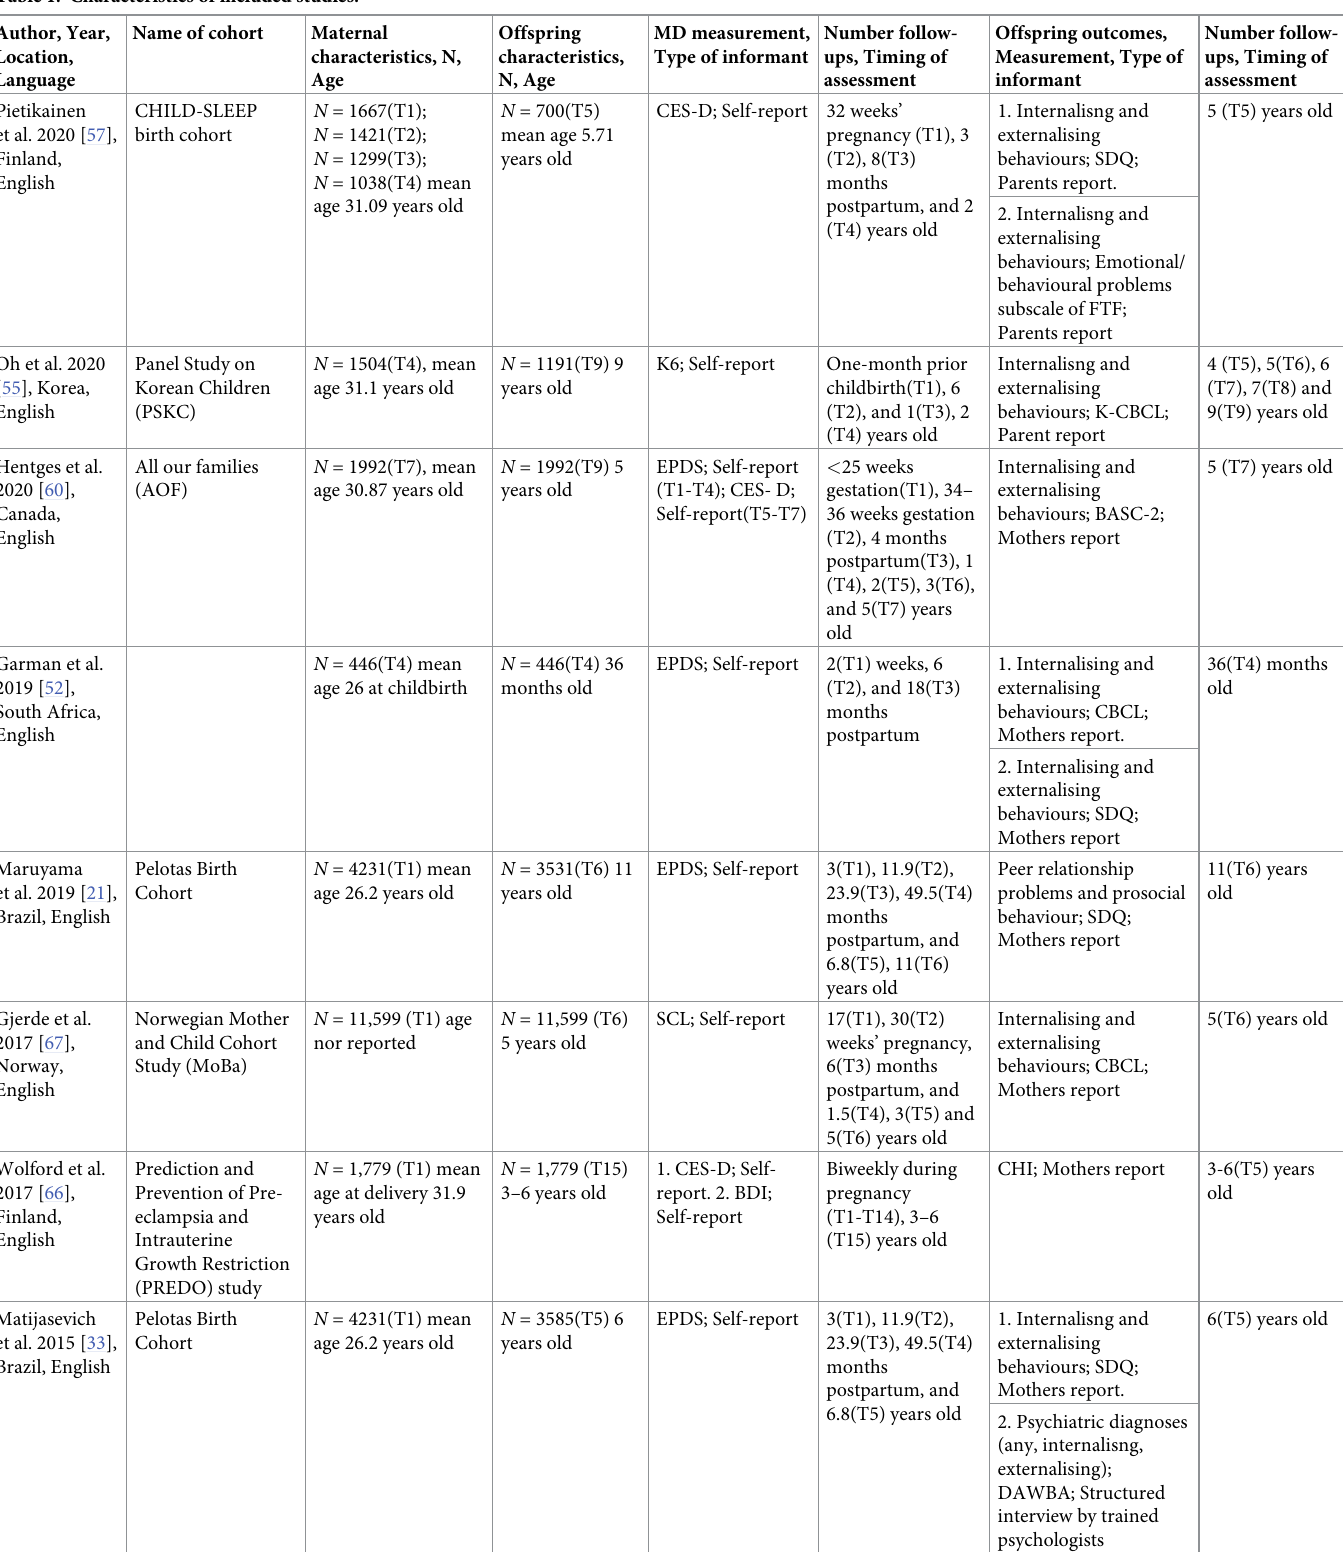
Table 1. Characteristics of included